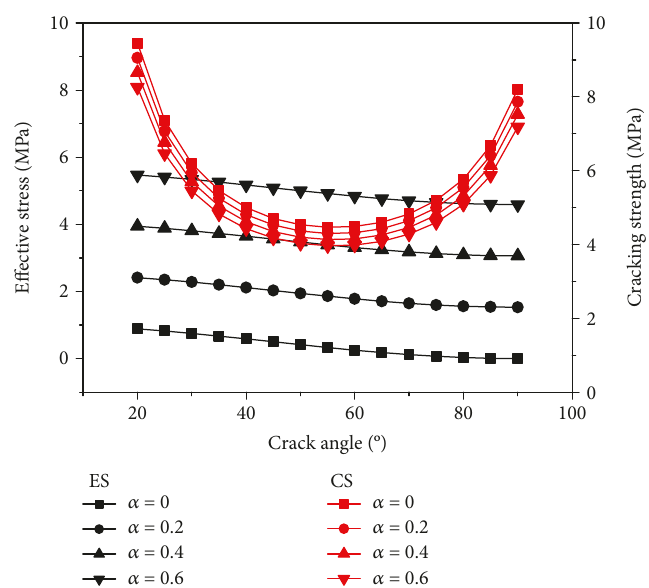
Figure 14: Relationship of e ff ective stress against crack angle under di ff erent gas desorption